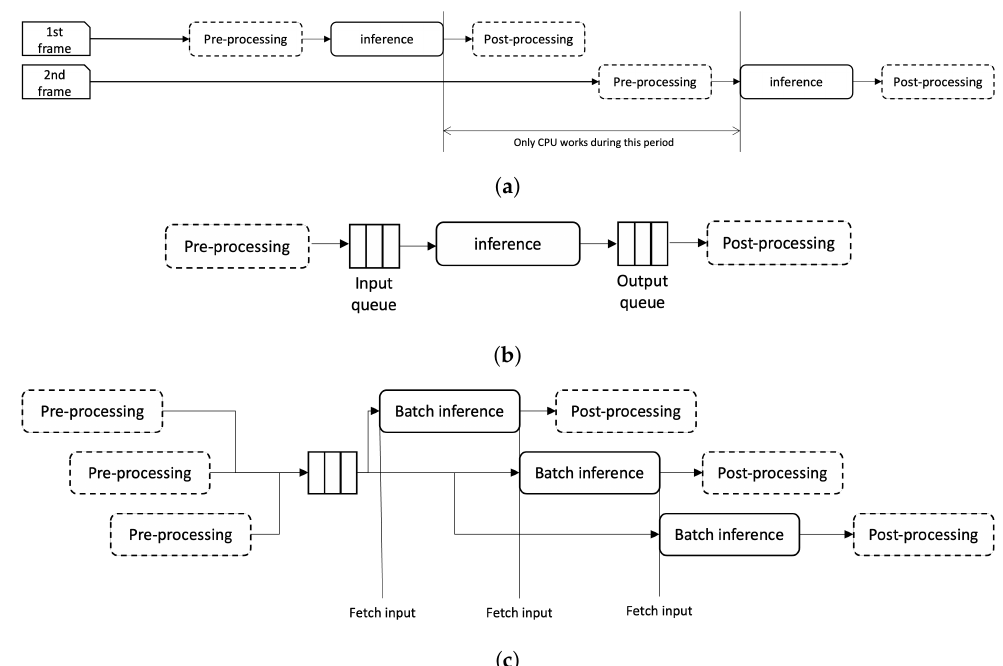
Figure 3. Inference pipelines. ( a ) Sequential processing of a video input. ( b ) Pipeline of sequential processing. Each process is separated with a queue. ( c ) Batch inference pipeline. Input data are stacked on a queue, and inference fetches a batch of images. Lined boxes refer processes that make use of GPU while dotted boxes refer those of